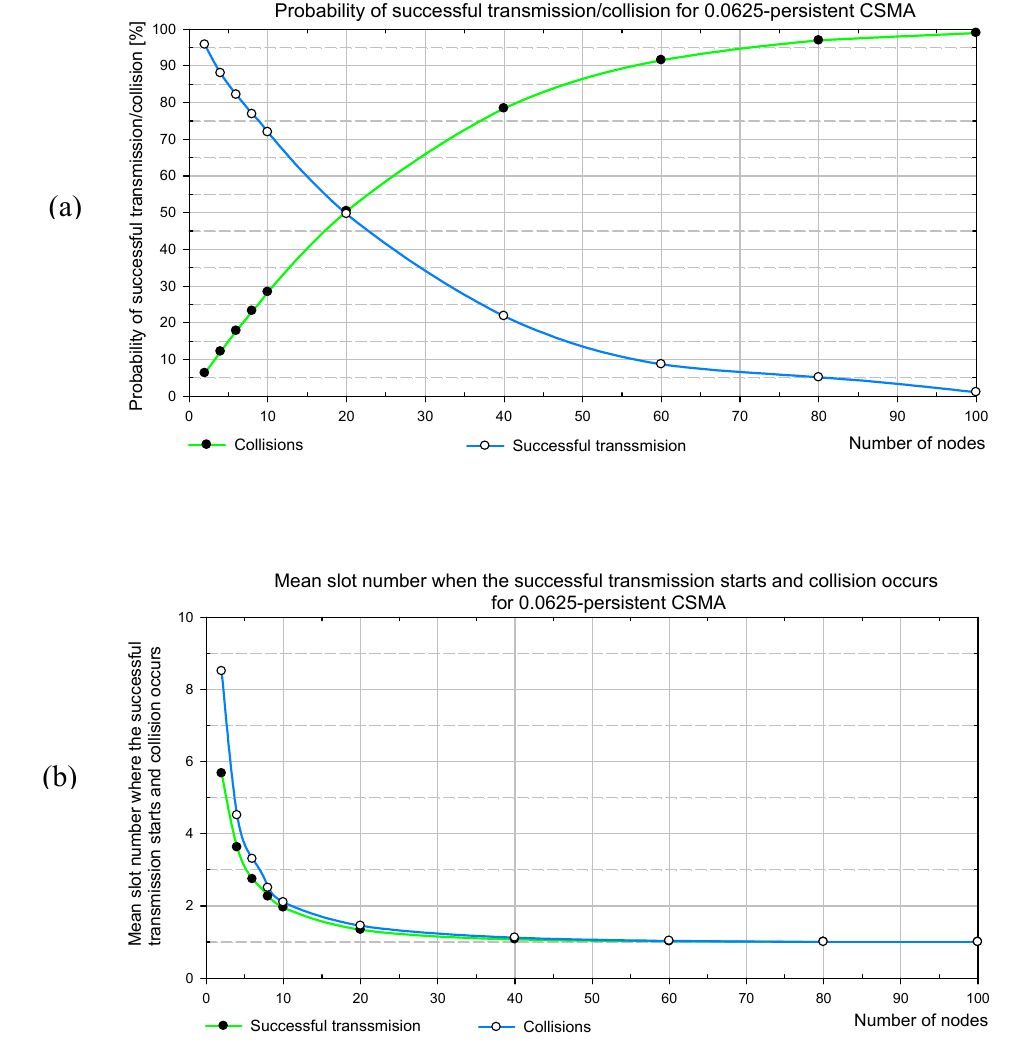
and a collision )( )1( np (a); the mean slot succ coll , and the collision occurs )( )1( nd (b) versus succ coll the number of nodes.